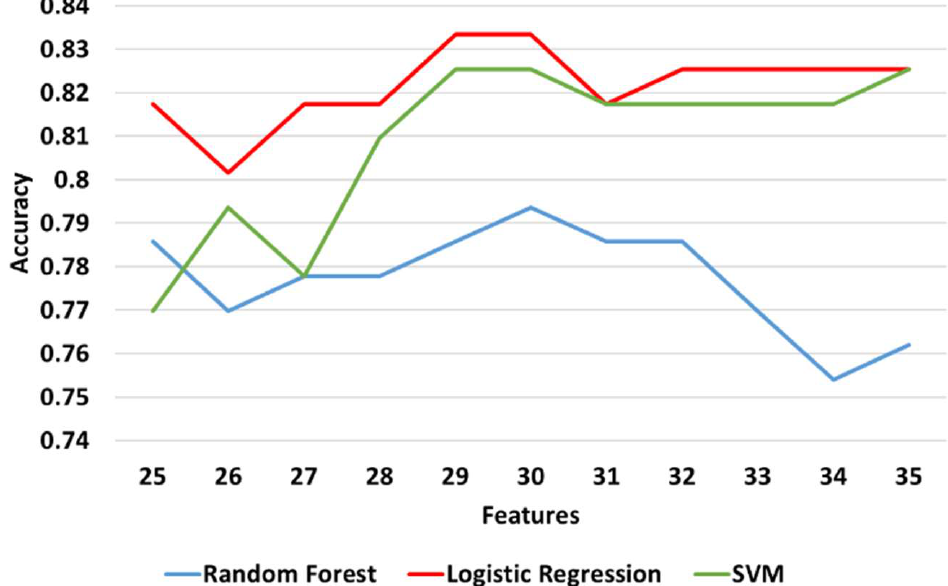
Figure 10. The accuracy of LR, RF (random forest), and SVM from 25 to 35 features over the test set for left and right legs combined. Results are shown with a step size of 1 (one feature added at each